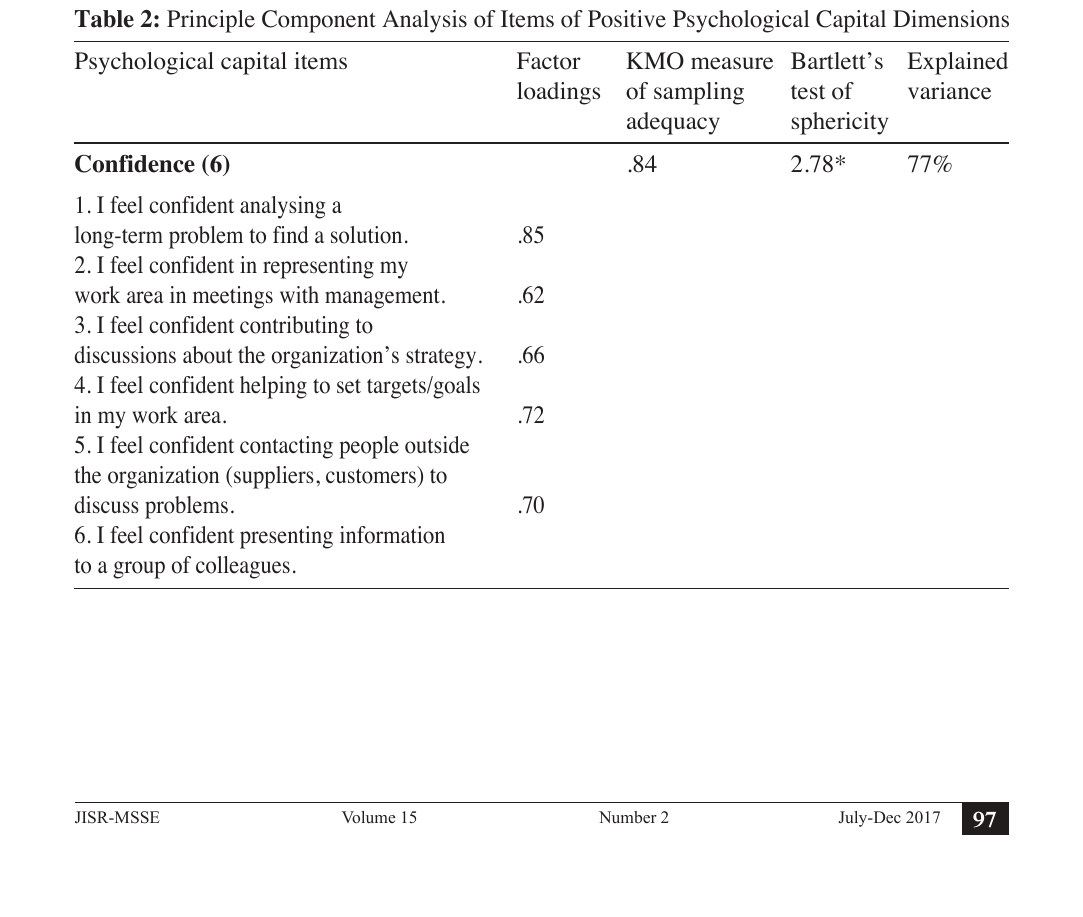
Table 2: Principle Component Analysis of Items of Positive Psychological Capital